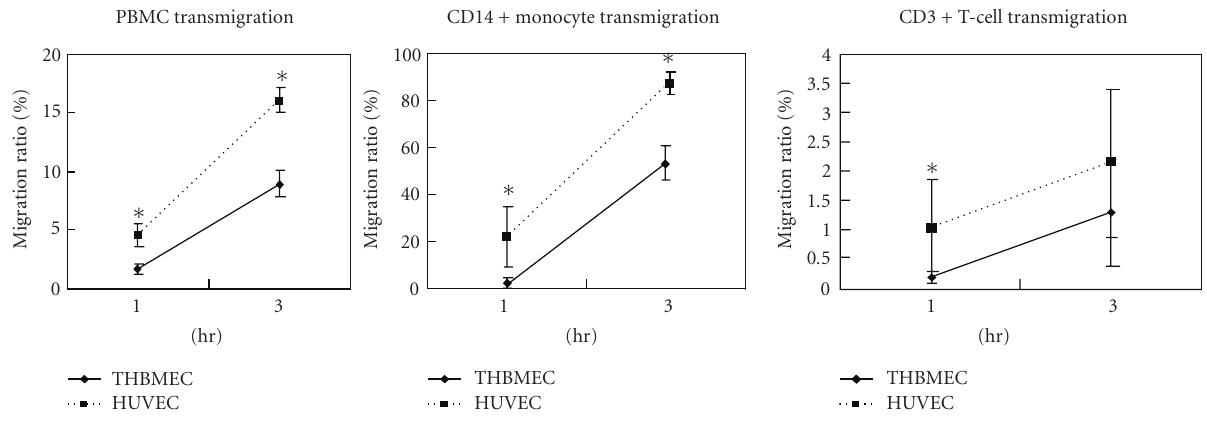
Figure 3: THBMEC cultures are more restrictive towards PBMCs transmigration than HUVECs. 10 6 of PBMCs were added into the transwell inserts containing confluent THBMECs or HUVECs and allowed to transmigrate for the indicated time. Migrated cells were collected and three color stainings were performed in one step using anti-CD3 PerCP and anti-CD14 APC antibodies. Data were collected with an LSR flow cytometer and analyzed using FlowJo (cid:2) software. Parallel migration assays were performed using calcein-AM labeled and unlabeled PBMCs, and migration ratios calculated as stated in Section 2. The assays were performed in quadruplicate using four di ff erent donors. Confluent HUVEC cultures are more permissive towards PBMCs migration than THBMECs. ∗ indicates P < . 05 comparing THBMECs with HUVECs. PBMCs transmigration across these endothelial cultures follows the pattern: monocytes > T cells > B cells (data about B cells not